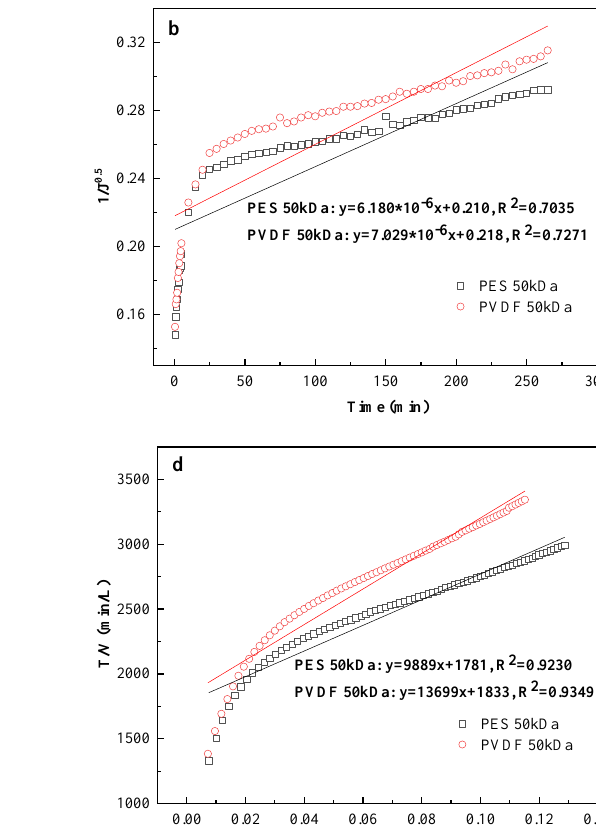
Figure 8. ( a ) Exponential fouling coefficient ( 𝐾 values of the two membranes under different operating conditions.